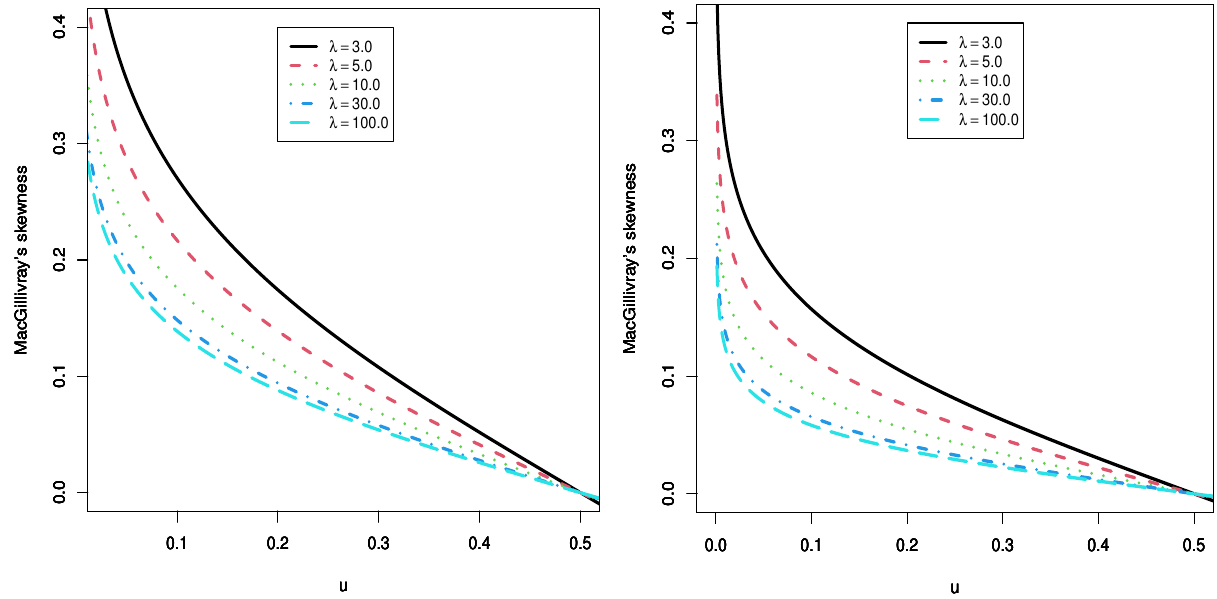
Figure 8. Plots of the MacGillivray’s skewness for FB distribution at p = 0.7 and n =